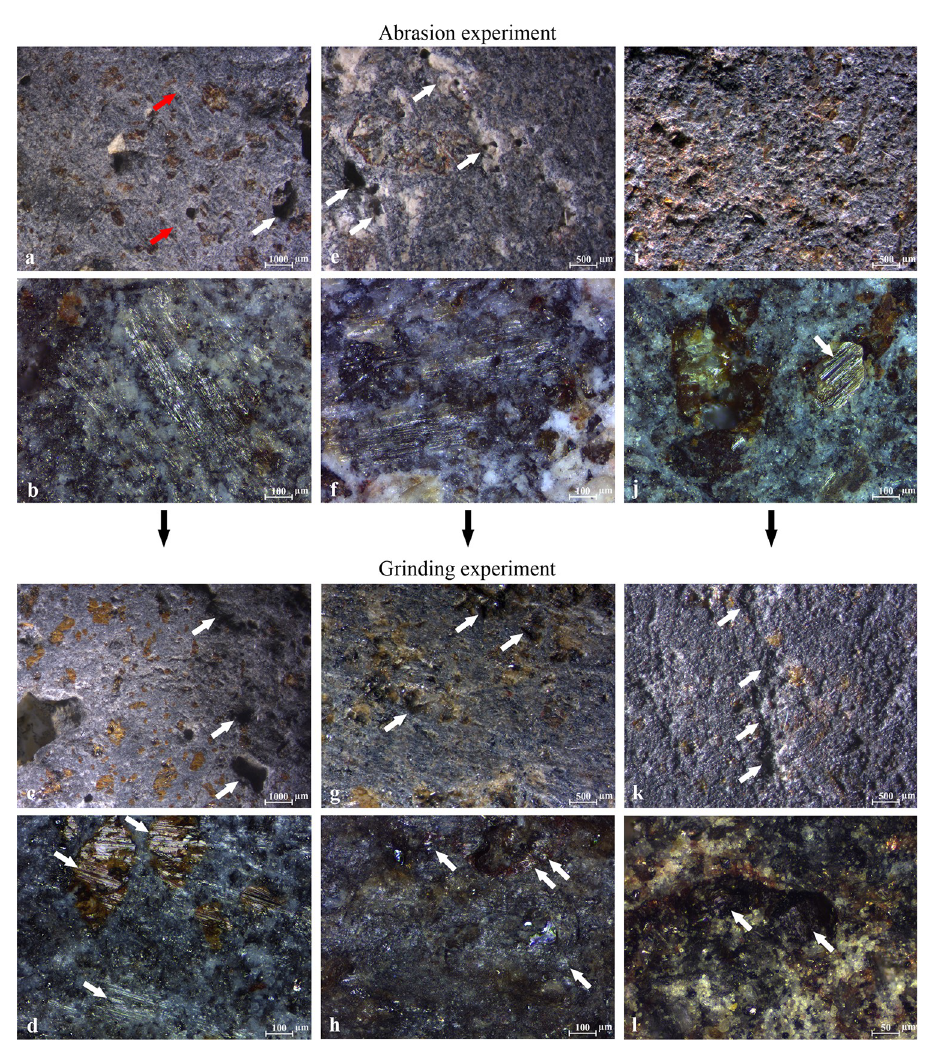
Fig 5. Macro- and micro-scale use-wear observed on the experimental basalts. (a, b) Traces by abrading with aeolianite: (a) Flat leveled surface, isolated amorphous pits with sharp edges marked by an arrow, and striations marked by red arrows (10x); (b) A polished surface with a patch of connected intermittent striations (100x); (c, d) Traces by grinding oat on the surface abraded with aeolianite: (c) Sinuous regular surface and pits with rounded edges marked by arrows (10x); (d) A polished surface associated with flat bright striated patches of polish produced by the contact with the upper stone, marked by arrows (100x); (e, f) Traces by abrading with aeolianite and sand: (e) Sinuous regular surface and diffuse pits with rounded edges and bottoms marked by arrows (20x); (f) A polished surface with patches of connected intermittent striations (100x); (g, h) Traces by grinding rosemary on the surface abraded with aeolianite and sand: (g) Flat regular surface and pits with relatively sharp edges marked by arrows (20x); (h) Translucent irregular covering polish, developing a reticular pattern on protruding surfaces, marked by arrows (100x); (i, j) Traces by abrading with beachrock: (i) Flat rough irregular surface and amorphous pits with irregular bottoms (20x); (j) A patch of flat striated polish on top of the olivine, marked by an arrow (100x); (k, l) Traces by grinding flax seeds on the surface prepared with beachrock: (k) Flat irregular surface, protruding topography moderately rounded, and diffuse recesses with rough edges and bottoms marked by arrows (20x); (l) Thin, rough, dull, transparent polish covering the surface and patches of developing reticular pattern marked by arrows (100x) (see also Tables 3 and 4).